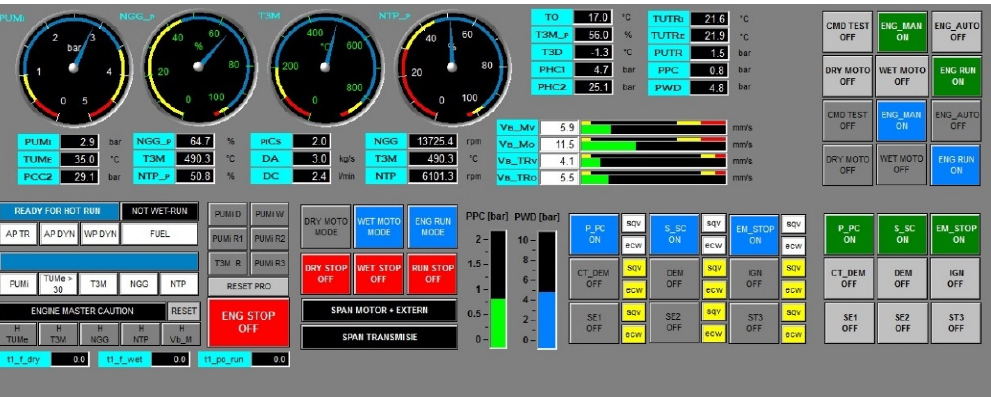
Figure 9. Engine graphical user interface.